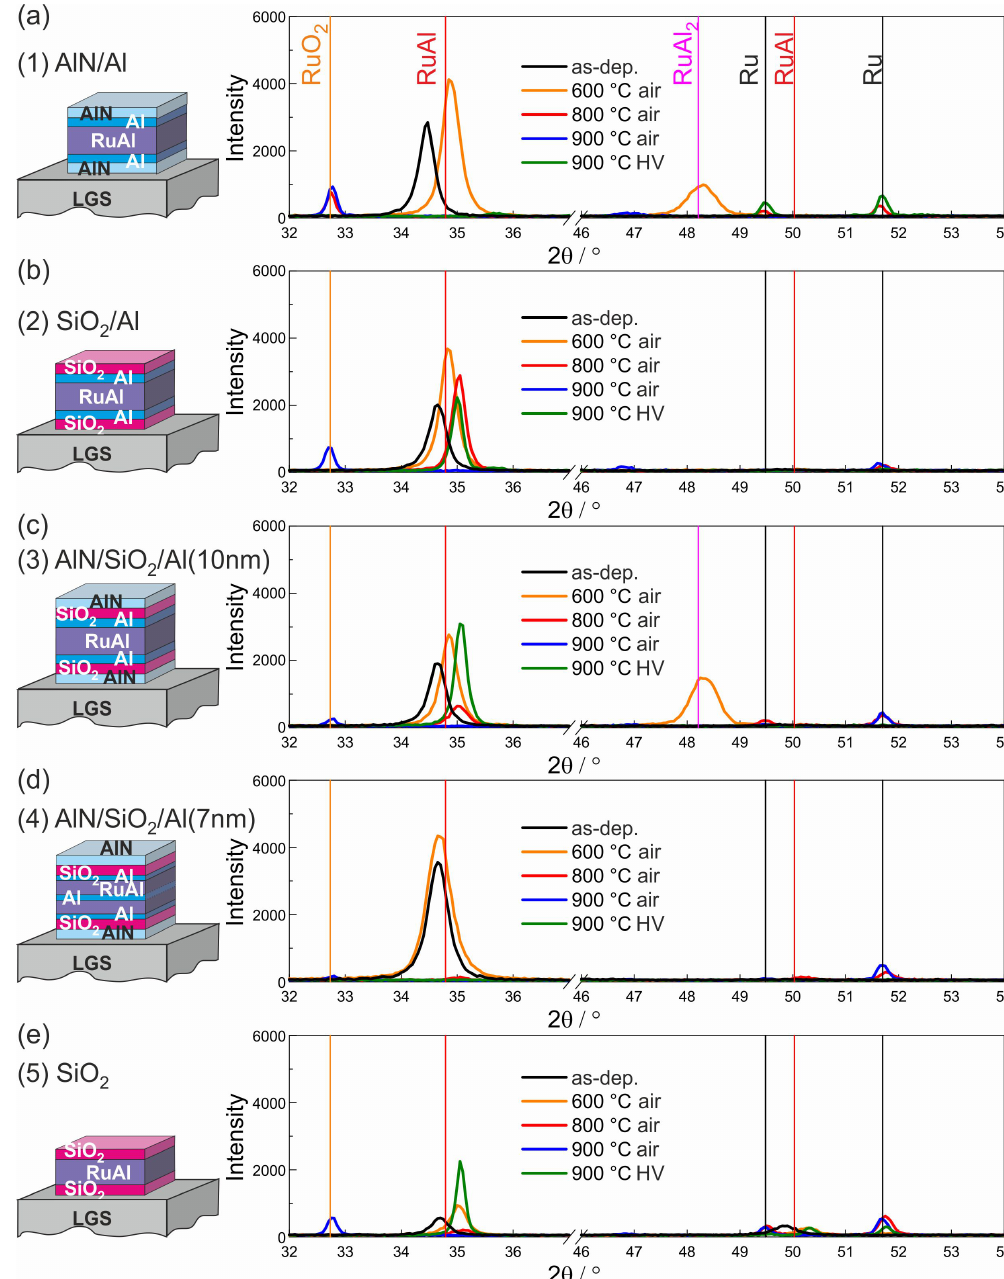
Figure 8. Results of the XRD measurements (Bragg–Brentano, Co-K α ) for the samples with the different cover and barrier layers on LGS substrates: ( a ) (1)-AlN/Al, ( b ) (2)-SiO 2 /Al, ( c ) (3)-AlN/SiO 2 /Al(10 nm), ( d ) (4)-AlN/SiO 2 /Al(7 nm), and ( e ) (5)-SiO 2